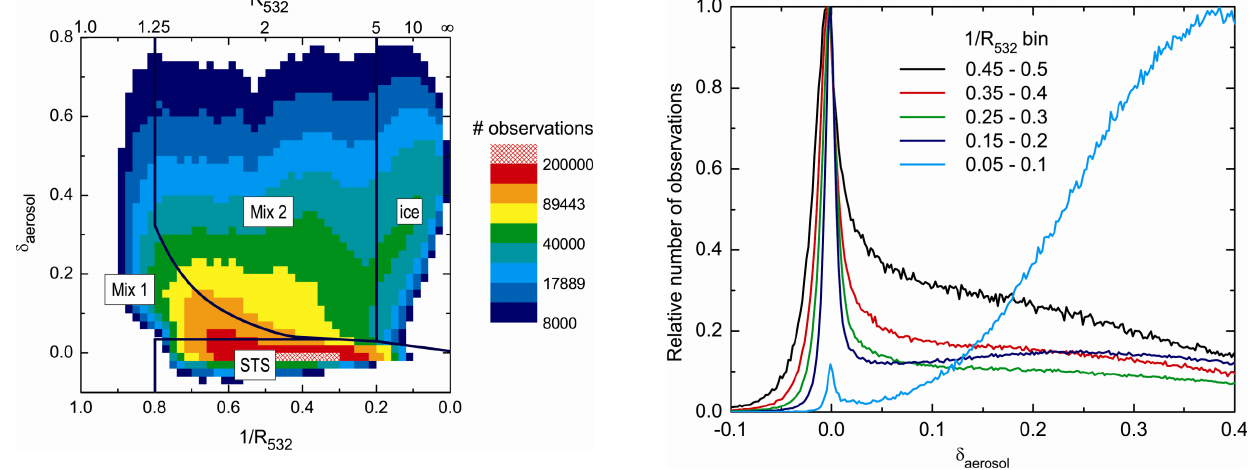
Figure 7. Composite histogram of CALIPSO PSC observations for Antarctic 2006-2008 seasons and Arctic 2006/07-2007/08 seasons, with new composition classification boundaries. Fig. 7. Composite histogram of CALIPSO PSC observations for Antarctic 2006–2008 seasons and Arctic 2006/2007–2007/2008 seasons, with new composition classification boundaries.